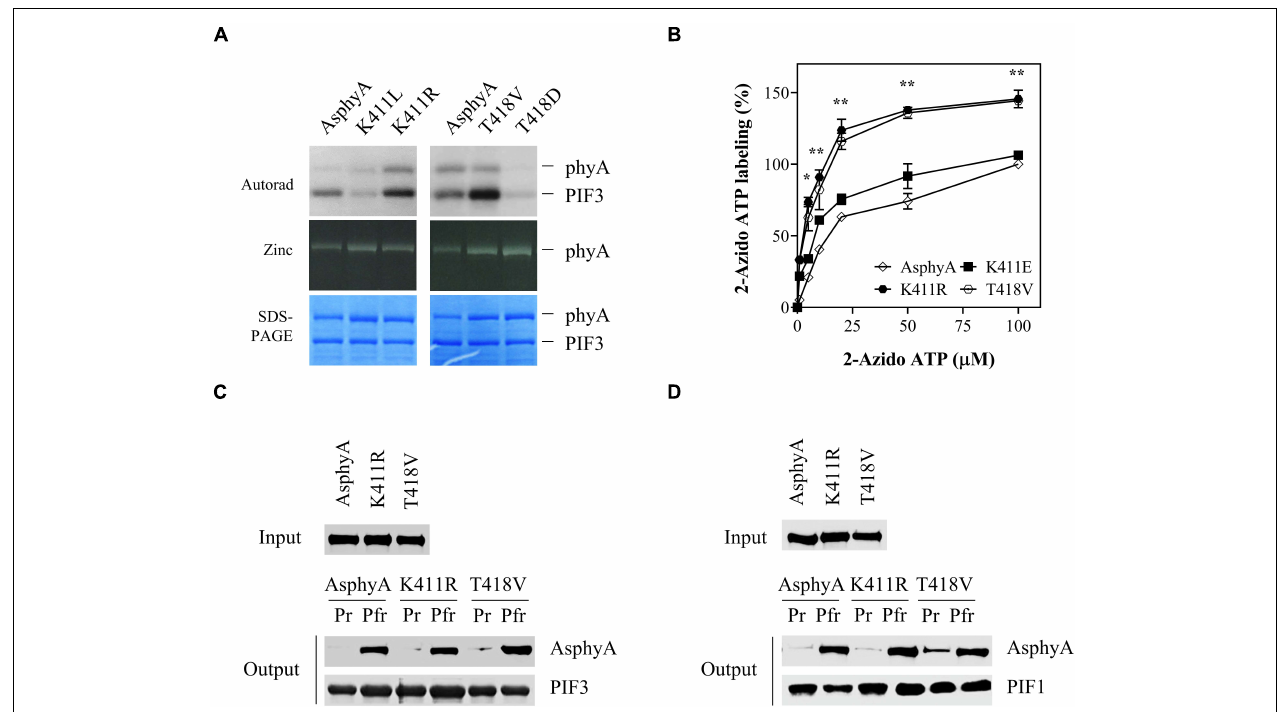
FIGURE 1 | Avena sativa phytochrome A (AsphyA) mutants with increased kinase activity. (A) Kinase activity assays of AsphyA mutants with phytochrome-interacting factor 3 (PIF3) as a substrate. 1.0 µ g of GST/strep-fused PIF3 ( ∼ 0.3 µ M) was added in reaction mixtures with 1.0 µ g of full-length AsphyA protein ( ∼ 0.2 µ M; Pfr form). Autoradiograms (top), zinc fluorescence images (middle), and SDS-PAGE gels (bottom) are shown. (B) ATP-binding affinity assays of AsphyA mutants using photoaffinity labeling with 2-N 3 -ATP-biotin-long chain-hydrazone (2-azido-ATP). A total of 2.0 µ g of full-length AsphyA protein ( ∼ 0.16 µ M) was labeled with the indicated concentrations of 2-azido-ATP. The percentages of 2-azido-ATP labeling were obtained assuming the wild-type AsphyA labeling with 100 µ M azido-ATP as 100%. Data represent means ± SD from three independent measurements. Significant changes in comparison to wild-type AsphyA are indicated (* P < 0.05 and ** P < 0.01, as determined using Tukey’s test). (C,D) In vitro protein–protein interaction analyses of AsphyA mutants with PIF3 and PIF1. A total of 2 µ g of full-length AsphyA (either Pr or Pfr form) was incubated with 2 µ g of GST/strep-fused PIF3 (C) or PIF1 (D) at 4 ◦ C for 60 min. Glutathione bead-bound proteins were then pelleted and analyzed by western blotting with anti-AsphyA (oat25) or anti-GST (sc-138) monoclonal